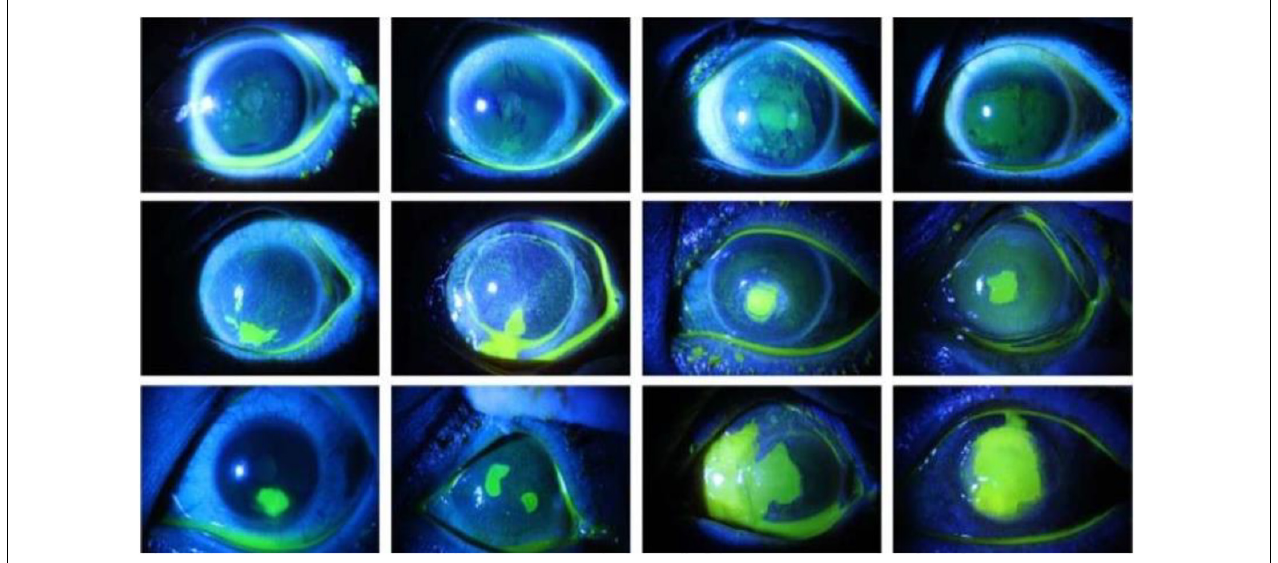
FIGURE 1 | Comparison of the three types of corneal ulcers, with the top row representing point-like corneal ulcers, the middle row representing point-flaky mixed corneal ulcers, and the bottom row representing flaky corneal ulcers.